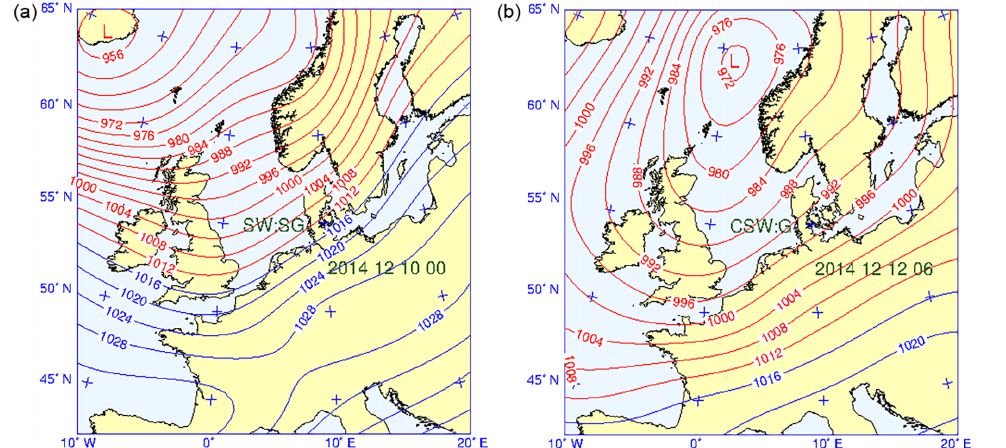
Figure 2. Classification of the general weather circulation (GWC) after the modified Lamb weather types used at BSH for (a) the low- pressure systems Alexandra (classification: south-west (SW) with severe gale (SW)) and (b) Billie (classification: cyclonal south-west (CSW) with gale (G)). Image credit: P. Löwe (BSH Hamburg).